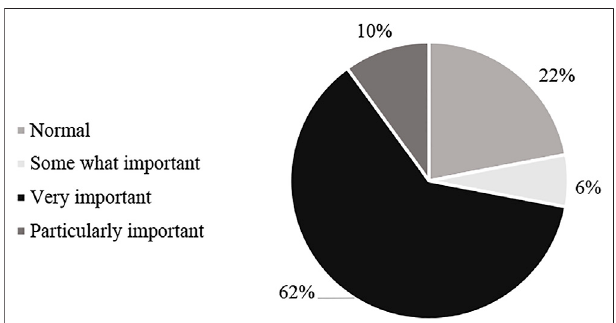
FIGURE2| Thepercentageofpeopleratingtheimportanceoftheforest to the family livelihood